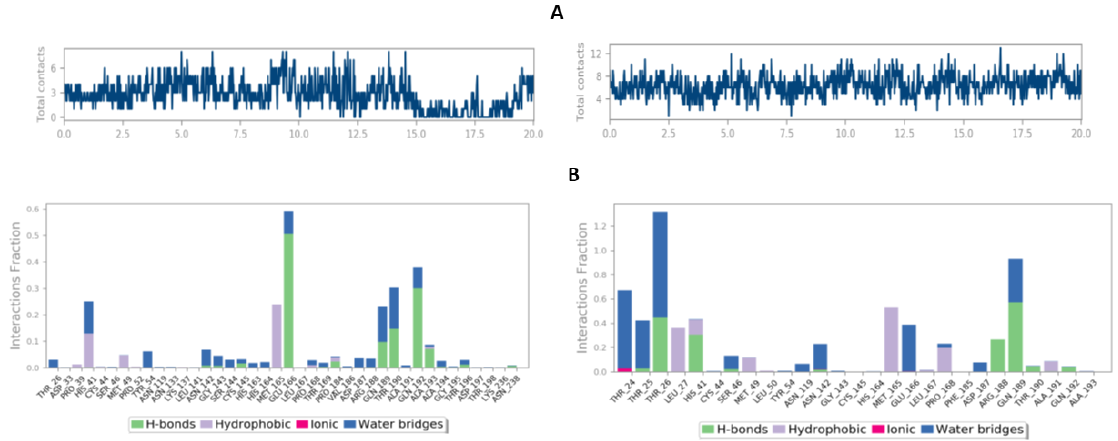
Figure 10. Results of the timeline of total residues contacts of main protease (PDB ID: 5R80) com- plexed with two reference (right ( A )) and 6i compounds (left ( A )). Bar chart of normalized molecular interactions throughout the run. The % of simulation time for the speci fi c interaction is shown in Y - axis that maintained of the complex Main protease (PDB ID: 5R80) complexed with Z18197050 (right ( B )) and 6i (left ( B )) compounds. The top panel ( A ) shows the total number of speci fi c contacts the protein makes with the ligand over the course of the trajectory. The ( B ) plot shows the interaction types with the corresponding residues between the reference ligand and 6i compound.